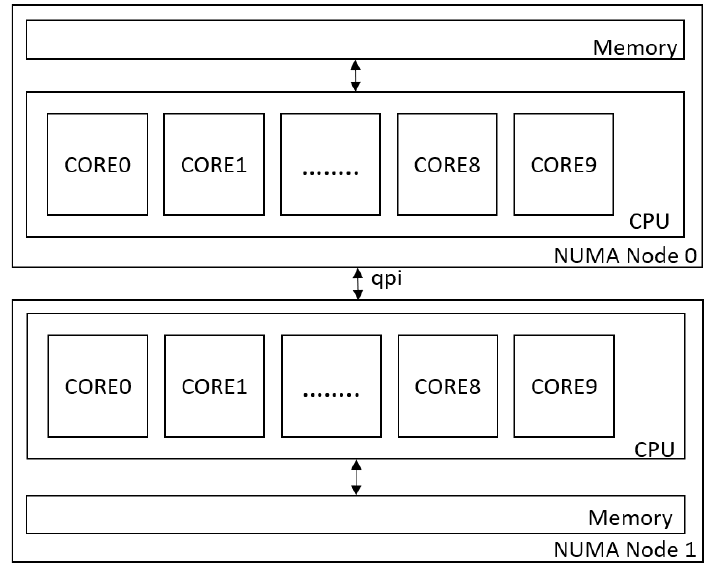
Figure 1. NUMA architecture.